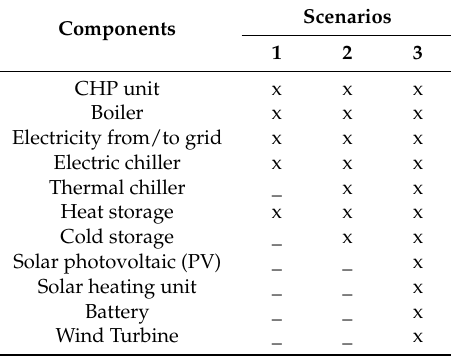
Table 1. Design scenarios.